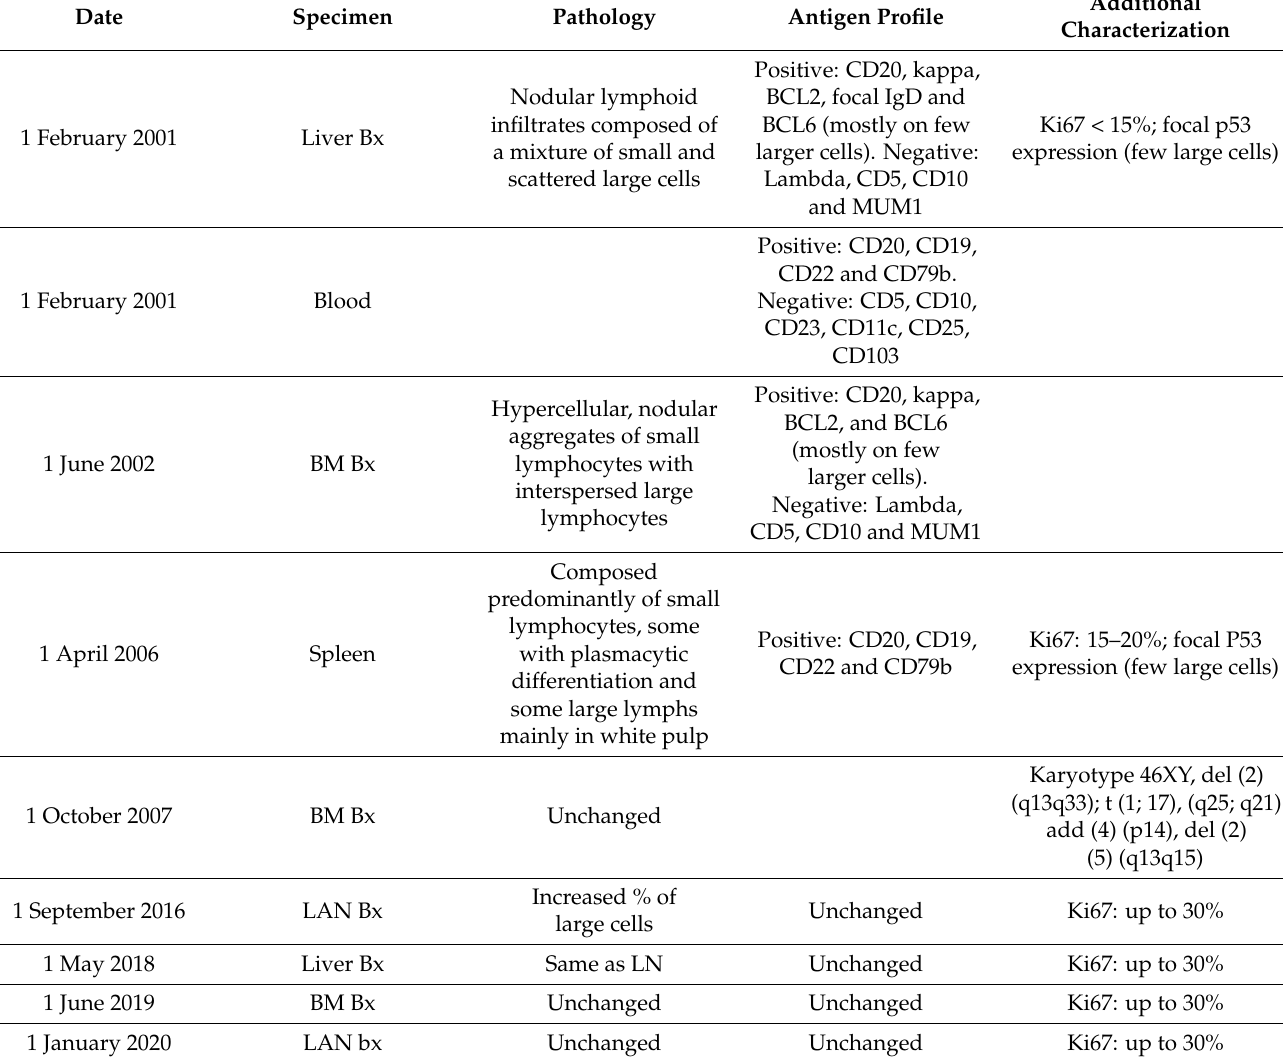
Table 1. Summary of tissue sample histology, immunohistochemical profile, and associated genetic